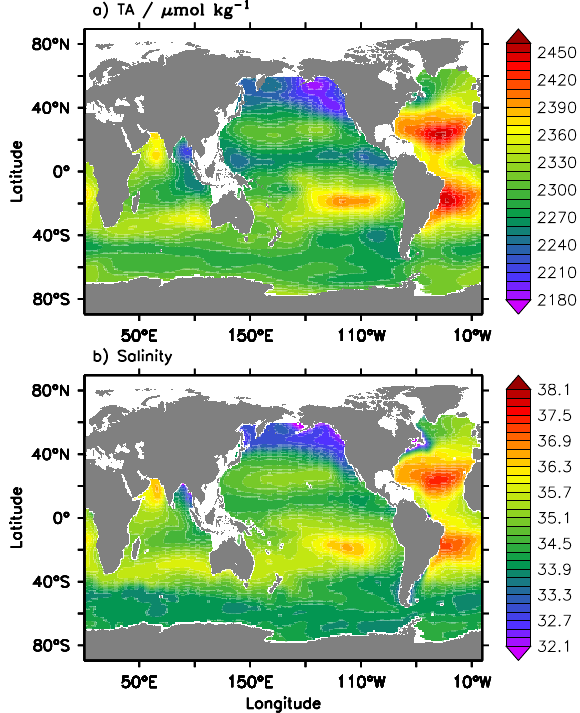
Figure 2. Surface ocean distribution of TA ( a , GLODAP, gridded data, http://cdiac.ornl.gov/ftp/oceans/GLODAP_Gridded_ Data/, last access: 10 December 2009) and salinity ( b , World Ocean Atlas, WOA, analysed annual means, Antonov et al., 2010). The scaling of the isolines was chosen to emphasize the global linear relationship between alkalinity (µmol kg − 1 ) and salinity. With ungridded bottle data from the upper 100m of the ocean (GLODAP/WAVES data set, http://cdiac3.ornl.gov/ waves/discrete/, last access: 31 March 2012) this relationship is TA = 699.75 + 46.18 · S ; r 2 = 0 .